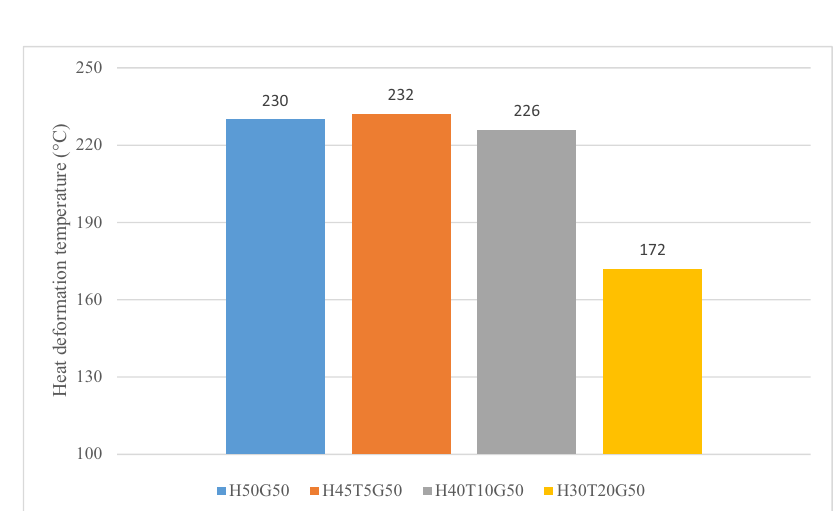
Figure 6: HDTs of H 50 G 50 , H 45 T 5 G 50 , H 40 T 10 G 50 , and H 30 T 20 G 50